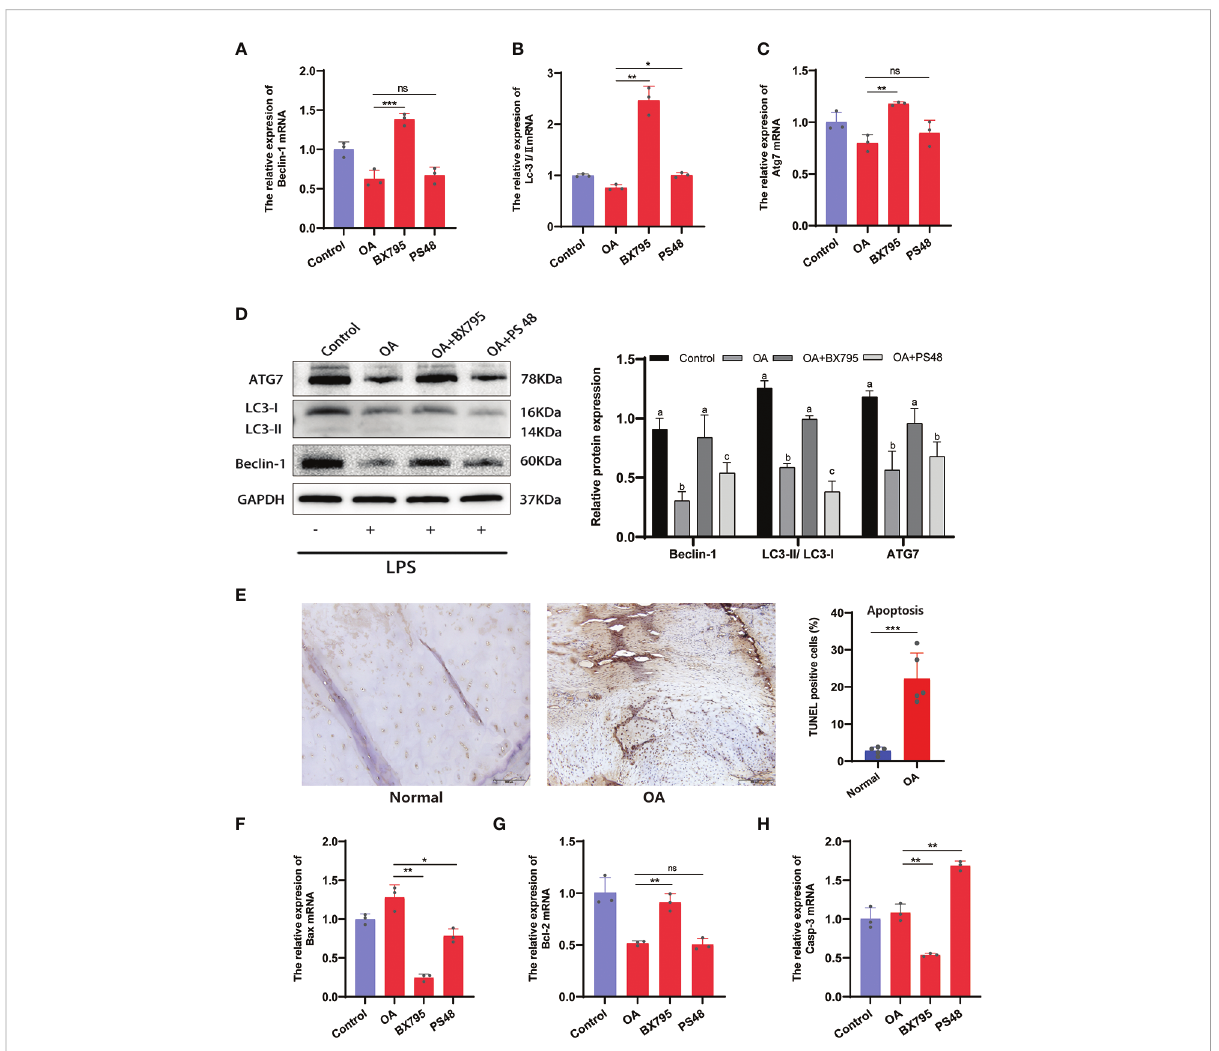
FIGURE 8 Inhibition of PDK1 expression restores OA-dysregulated autophagy and suppresses apoptosis. (A-C) Relative mRNA levels of Beclin-1, LC3I/II, and Atg7 by qRT-PCR. (D) The expression levels of autophagy-related proteins Beclin-1, LC3I/II, and Atg7 were detected by Western blot. In the quantitative plot, the bars with different letters are signi fi cantly different from each other, and the same letter represents no difference ( P <0.05). (E) Tunel staining between OA and normal cartilage tissues revealed that apoptosis was signi fi cantly higher in the OA group than in the normal group (scale bars=200 m m, n = 5). (F-H) Relative mRNA levels of Bax, Bcl-2, and caspase-3 (Casp-3) by qRT-PCR. Values are presented as means ± SD (n = 3). * p < 0.05; ** p <0.01; *** p < 0.001; ns, no signi fi cance, relative to the OA group. OA, osteoarthritis; SD, standard